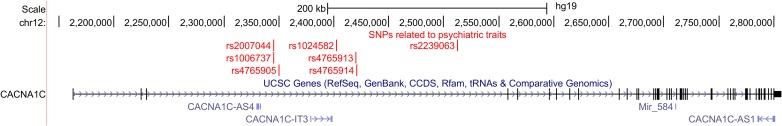
Location of studied SNPs at CACNA1C.Seven SNPs associated with psychiatric disorders are located in intron three of CACNA1C gene.